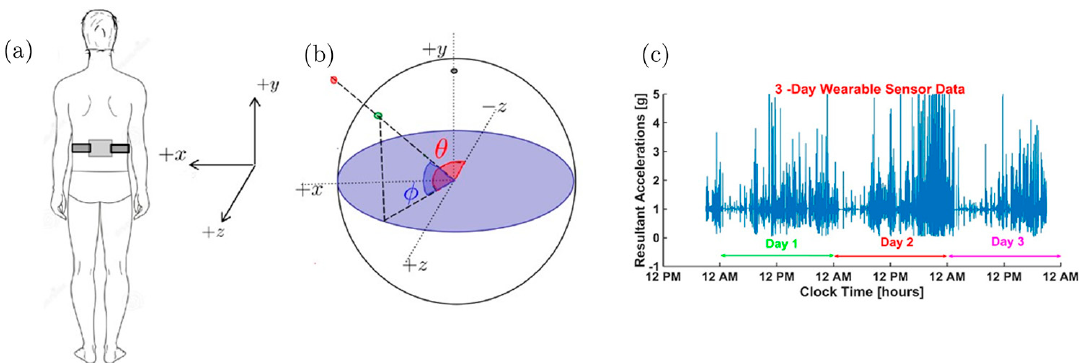
Figure 1. ( a ) Schematic diagram of an IMU worn by a participant. In this configuration, the positive acceleration in the x -direction (+a x ) is directed toward the left side, the +a y direction is pointed vertically upwards (opposing gravity), and the +a z -direction is pointed in the posterior direction. ( b ) Unit acceleration sphere (UAS): The axes refer to the acceleration axis in a sensor-centric left-handed coordinate system. The equatorial plane is shown in blue color. A sample acceleration point [ a x , a y , a z ] is shown as a red dot at some time. Its projection on the UAS is represented as the green dot. ( c ) Longitudinal 3-day resultant acceleration data.